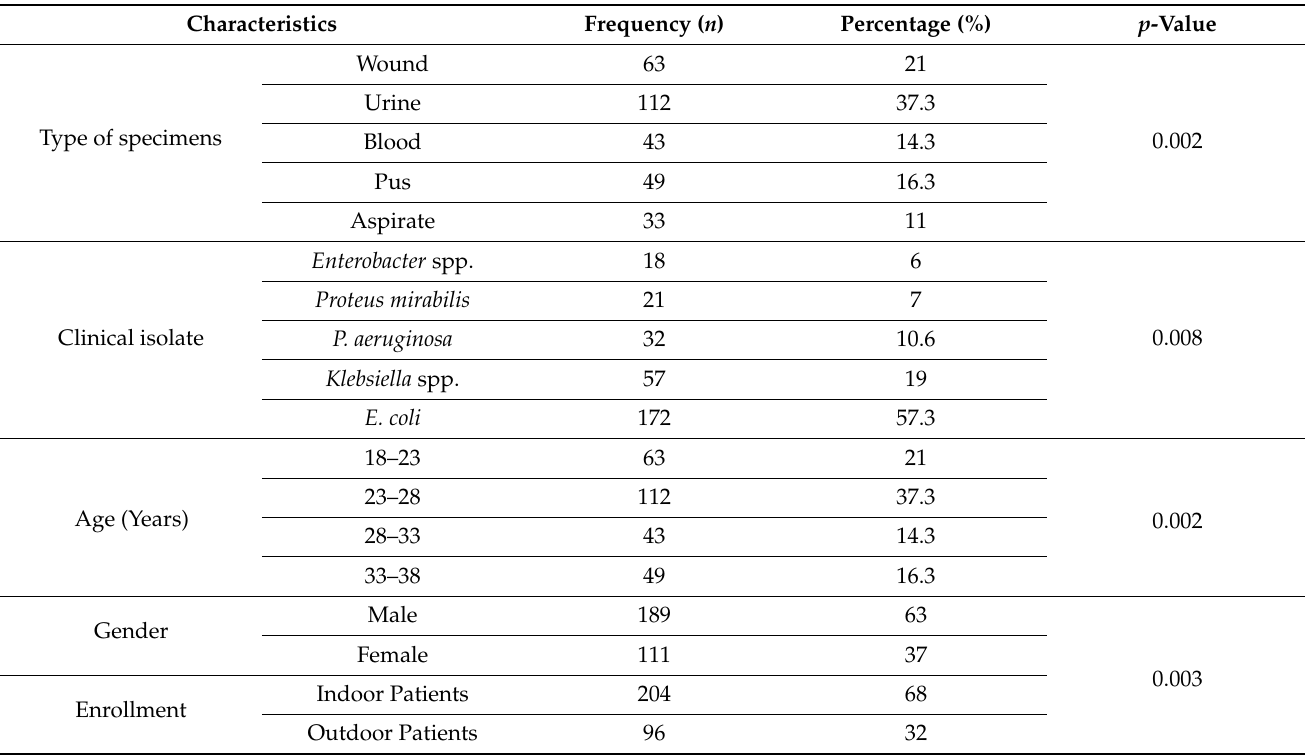
Table 1. Distribution of study variables.